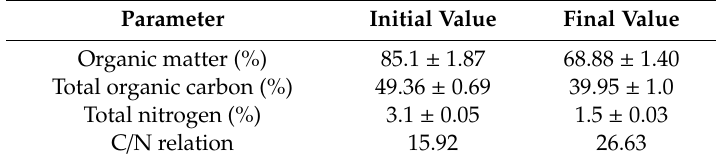
Table 1. Initial and final characterization of the pinapple waste in the pre-composting